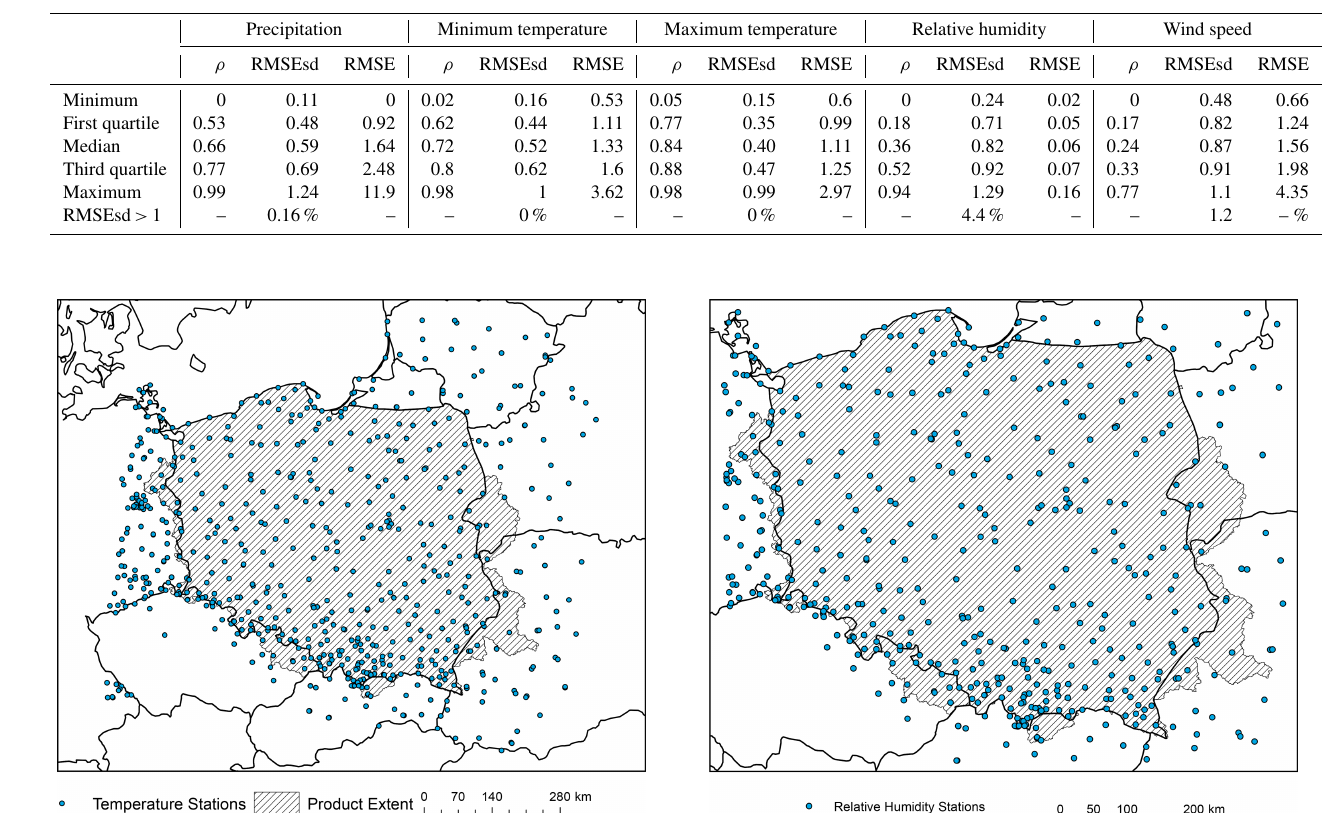
Table 1. Descriptive statistics for the kriging cross-validation results for precipitation, minimum temperature, maximum temperature, relative humidity and wind speed. “RMSEsd > 1” denotes the percentage of RMSEsd values higher than 1.